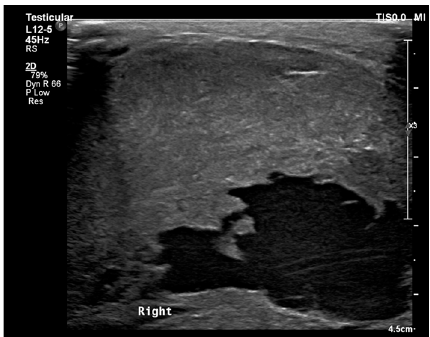
Figure 3: Ultrasound of right